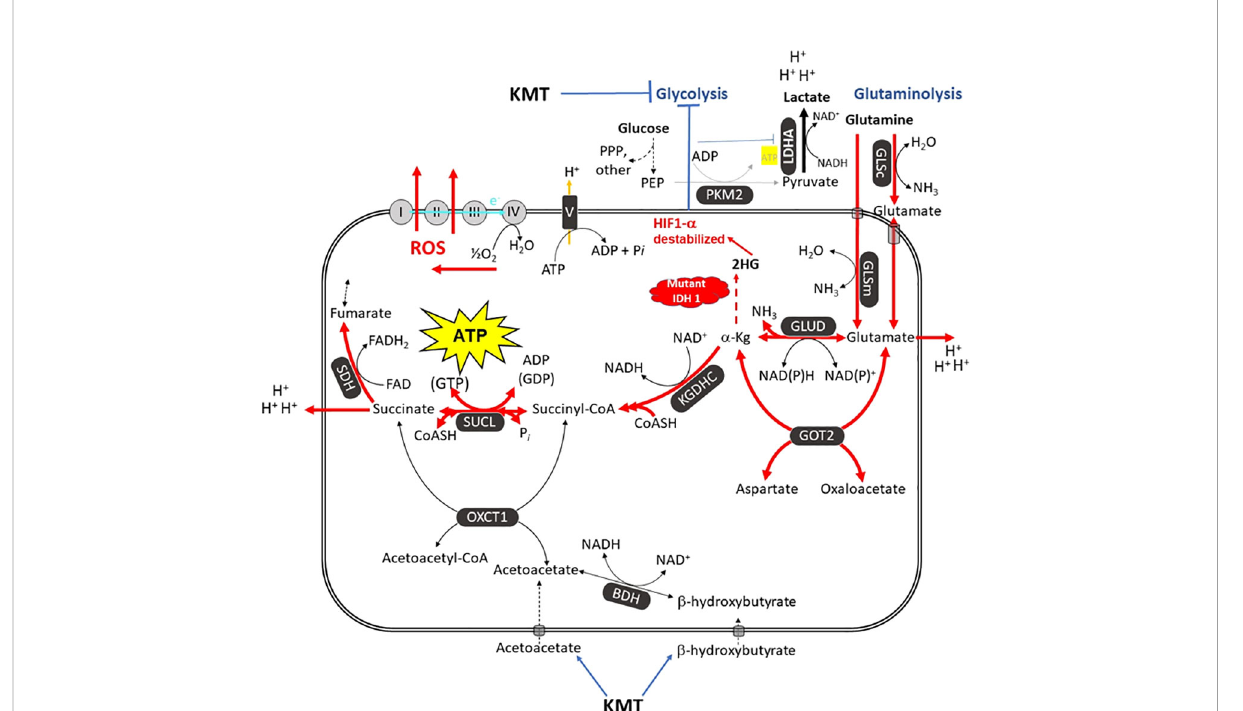
FIGURE 7 The metabolic pathways responsible for the acidi fi cation of the GBM microenvironment. GBM growth is dependent on glucose carbons for biomass synthesis through glycolysis and glutamine carbons for ATP synthesis through glutaminolysis. The glutamine nitrogen is necessary for protein and nucleic acid synthesis. The waste products of the glycolytic and the glutaminolysis pathways (lactic acid, glutamic acid, and succinic acid) will acidify the GBM microenvironment. The oxygen consumption is linked to ROS production, not to ATP synthesis. Excessive ROS produce somatic mutations and further increase in fl ammation and acidi fi cation of the microenvironment (7, 12, 14, 194). A calorie restricted KD will reduce glucose availability for glycolysis while also interfering with the glutaminolysis pathway (11). Glutamine-driven mSLP in the glutaminolysis pathway is a major source of ATP synthesis for GBM cells (7, 14). The glutaminolysis pathway (red) becomes dominant in tumor cells with inef fi cient OxPhos and that express the dimeric PKM2 isoform. PKM2 is expressed in GBM and produces less ATP through glycolysis than does the PKM1 isoform (73, 75, 195, 196). The elevation of ketone bodies (D- b -hydroxybutyrate and acetoacetate) through KD will indirectly reduce ATP synthesis through the succinate CoA ligase (SUCL) reaction by diverting CoA from succinate to acetoacetate. The IDH1 mutation could reduce ATP synthesis through mSLP by increasing synthesis of 2- hydroxyglutarate that is derived from a -ketoglutarate and thus reduce the succinyl CoA substrate for the SUCL reaction (11, 14, 197). Besides its potential effect in reducing glutaminolysis, 2-hydroxyglutarate can also target multiple HIF1 a -responsive genes and enzymes in the glycolysis pathway thus limiting synthesis of metabolites and one-carbon metabolism needed for rapid tumor growth (7, 14, 68, 198). The down regulation of Hif1- a - regulated lactate dehydrogenase A (LDHA), through the action of both the KD and the IDH1 mutation, will reduce extracellular lactate levels thus further reducing microenvironment in fl ammation, acidi fi cation, and tumor cell invasion. Hence, the simultaneous inhibition of glycolysis and glutaminolysis through the synergistic effects KMT and the IDH1 mutation will reduce the majority of signaling pathways necessary for rapid